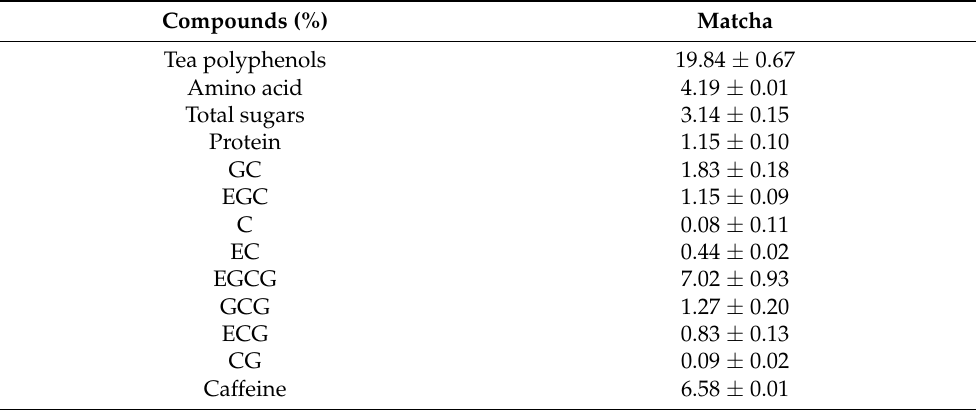
Table 2. Chemical analysis of the matcha sample.